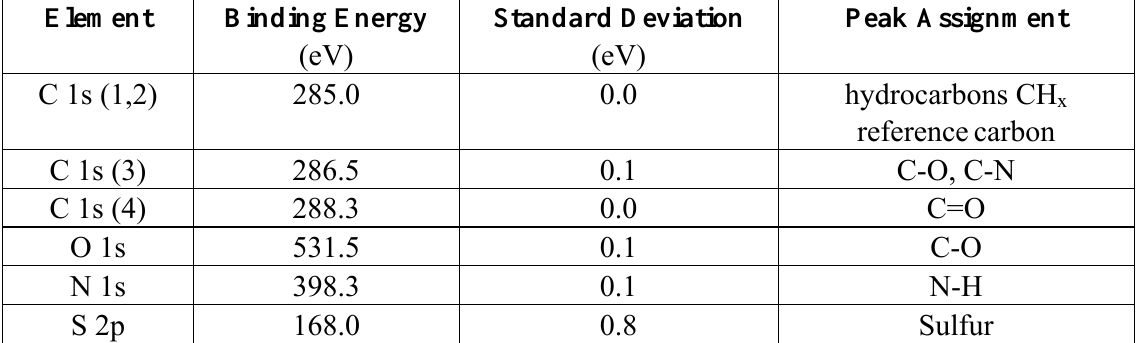
Table 1. Mean Binding Energy and Assignments of XPS Peaks Obtained for PTy-PNCnase